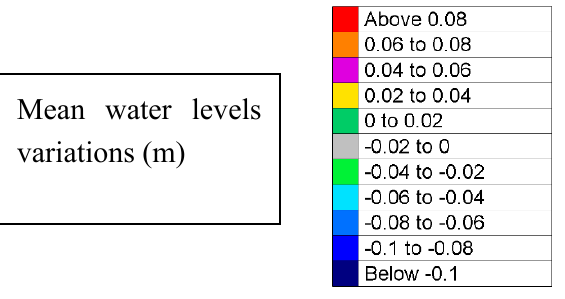
Figure 11. Mean modeled water levels variations (m) in the Vaccarès, the Impériaux, and the complex Lion/Dame lagoons for periods P1 to P7. For each period, the mean water level variation is estimated for each node of the mesh by calculating the difference of the mean water level during this period by the water level at the start of this